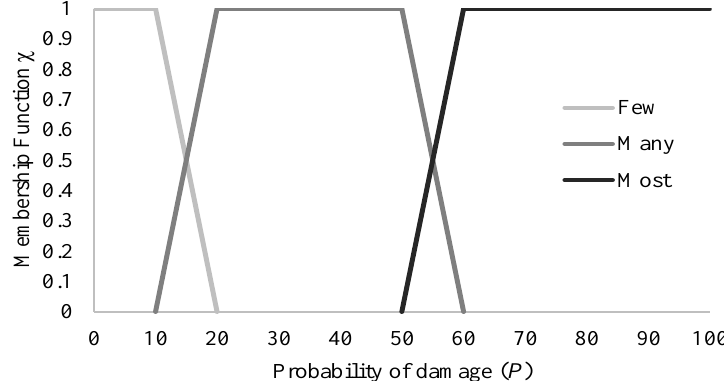
Table 3. Membership function for translation of qualitative terms to quantitative.